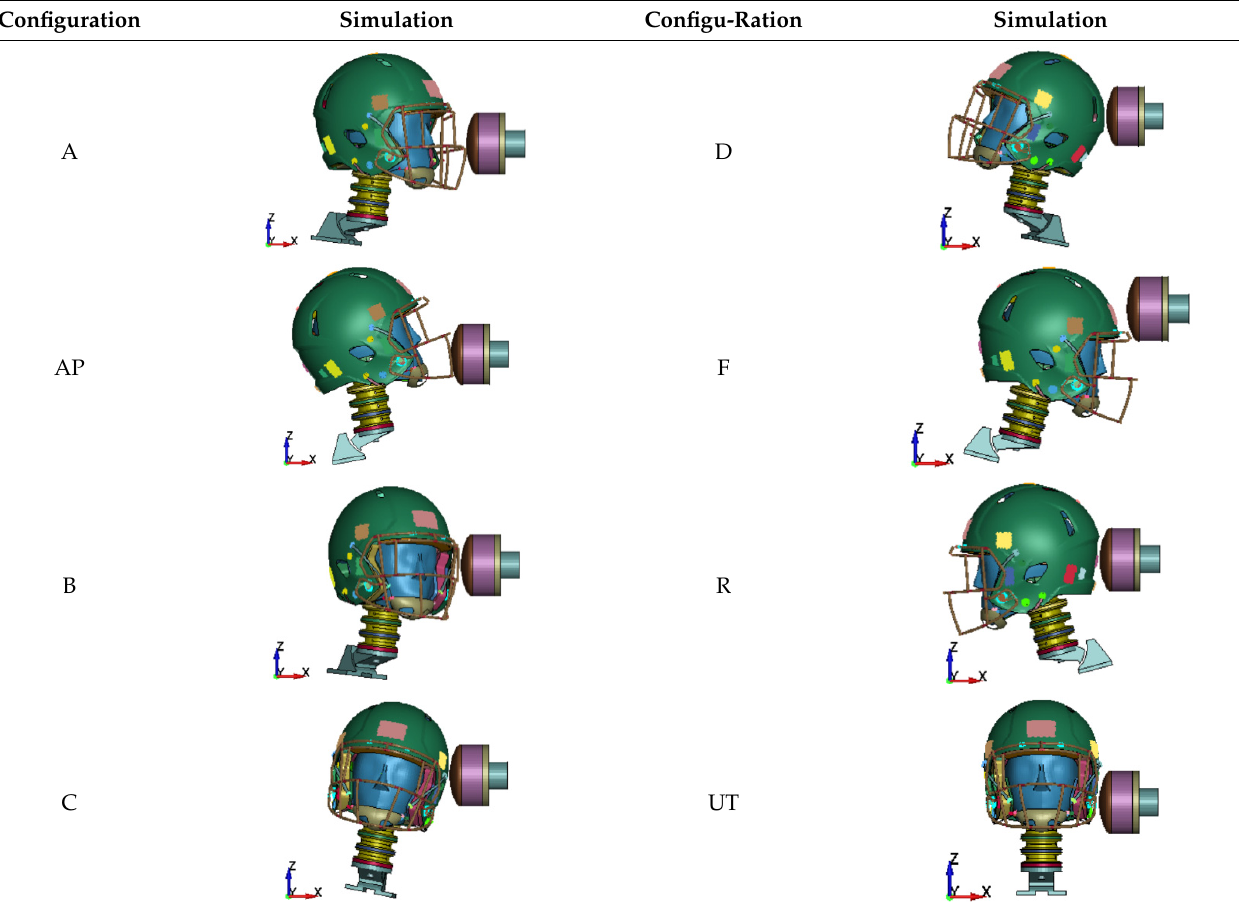
Table 4. Investigated approach Table 4. Investigated approach setup. Figure 6. Selected views of the helmet model (grey) with the α HEAD head model (colors). Table 4. Investigated approach setup. Table 4. Investigated approach setup. Table 4. Investigated approach setup. Table 4. Investigated approach setup. Table 4. Investigated approach setup.